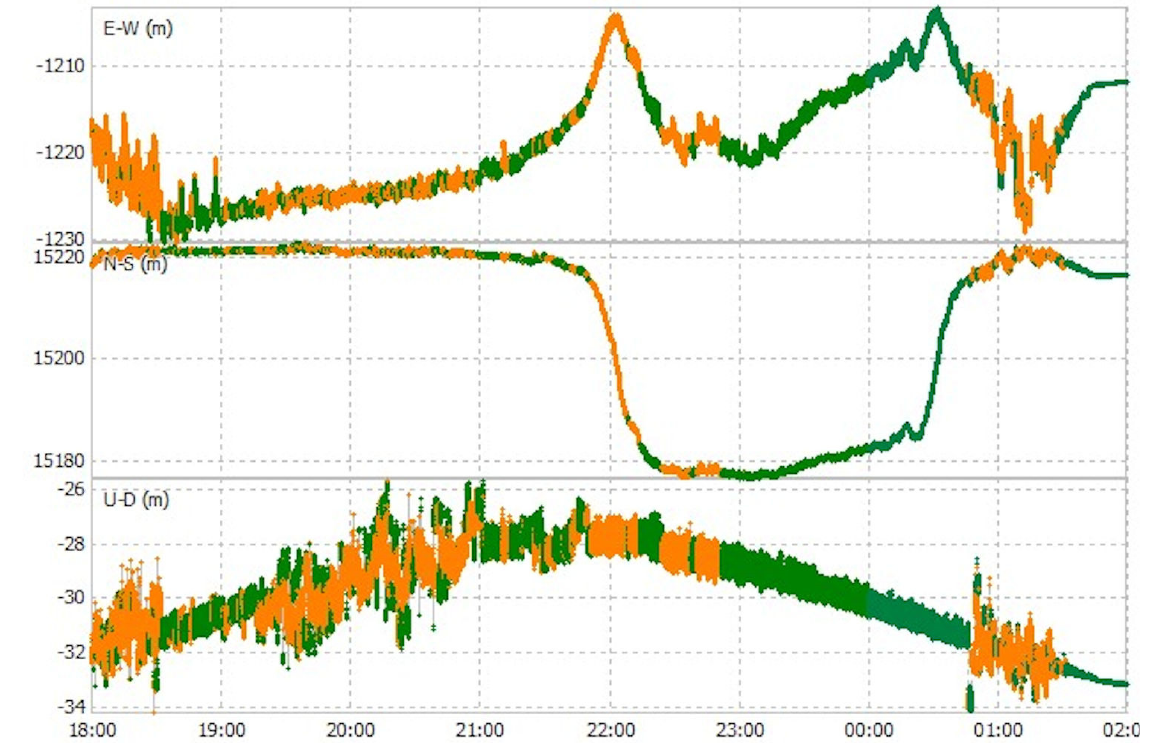
Figure 5. Buoy positional components during tidal cycle A; East–West (E-W), North–South (N-S) and Up–Down (U-D), 18:00 28 August–02:00 29 August. Fixed solutions (Q1) are shown in green, and float solutions (Q2) are shown in orange.